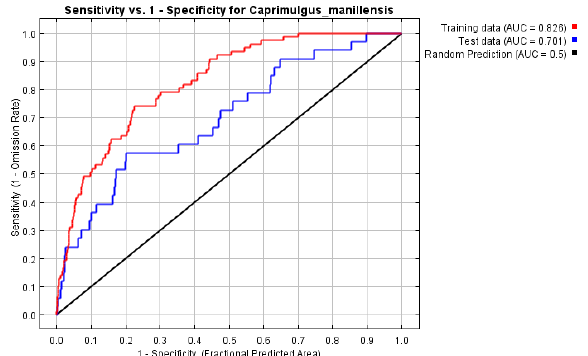
Figure 5. Sensitivity vs Specificity and AUC for C. manillensis